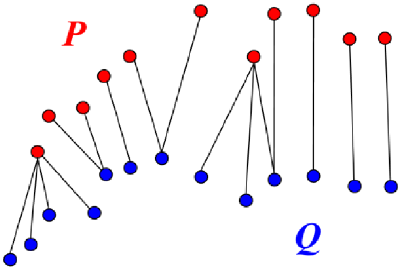
Figure 2. Example of point correspondences between point clouds P and Q .